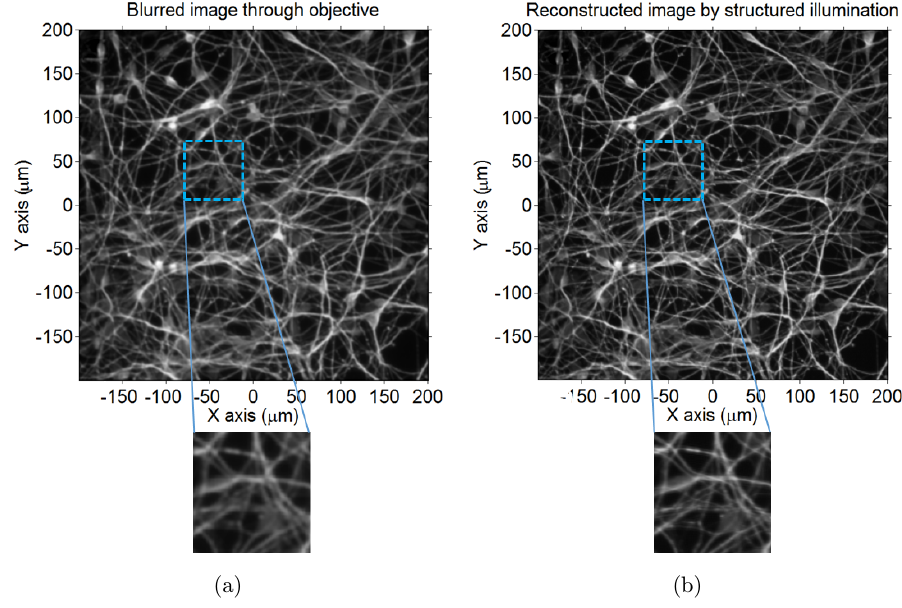
Fig. 6. Comparison of image resolution in conventional microscope and SIM. (a) Blurred image through objective in a conventional microscope and (b) Reconstruction image by structured